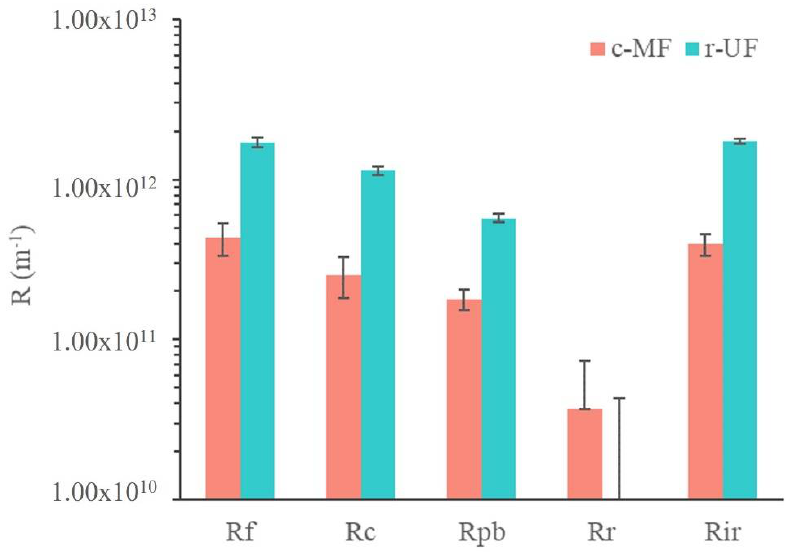
Figure 7. Estimated filtration resistances for the c - MF and r - UF membranes after stages Ib and